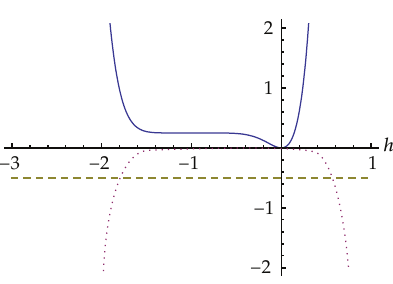
Figure 1: The ħ -curve of 8th-order approximation, dashed point: u (cid:2) 0 . 01 , 0 . 01 (cid:3) ; solid line: ¨ u (cid:2) 0 . 01 , 0 . 01 (cid:3) ; ... u (cid:2) dashed line: 0 . 01 , 0 . 01 (cid:3) .